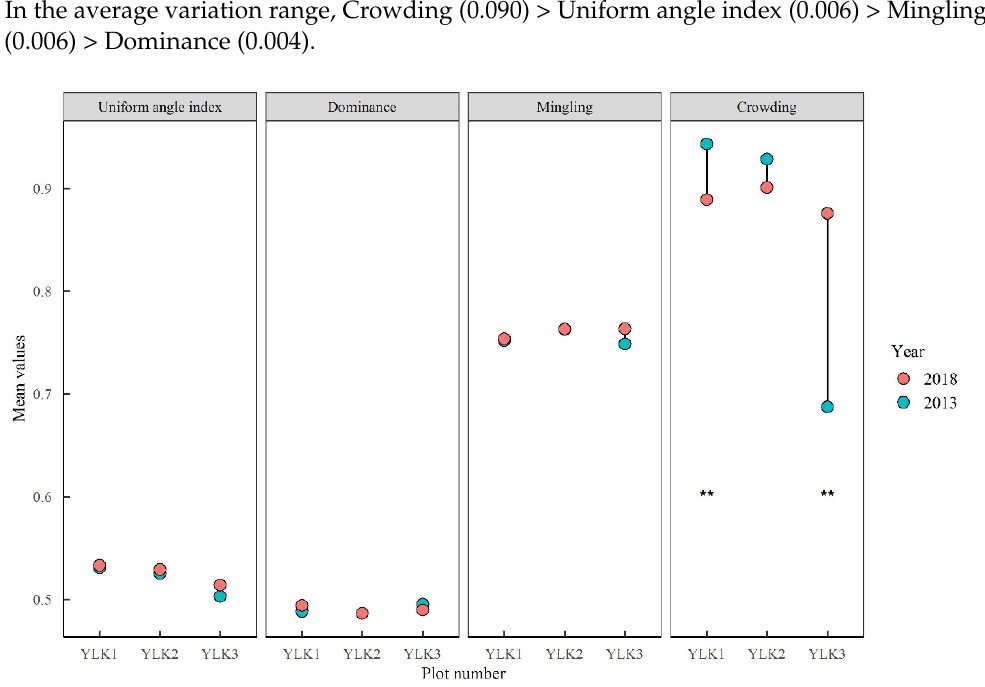
Figure 5. Changes in mean values of stand spatial structural parameters of plots from 2013 to 2018. The Chi-square test was used to check the significant difference between years for each of the four parameters of the five possible values (0, 0.25, 0.5, 0.75 and 1). Significant codes: p < 0.01 ‘**’.